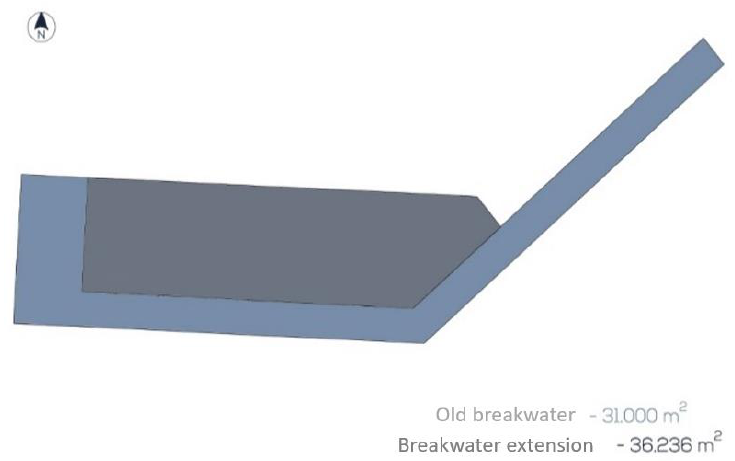
Figure 2. Distribution of the maintenance area to carry out the relevant work.